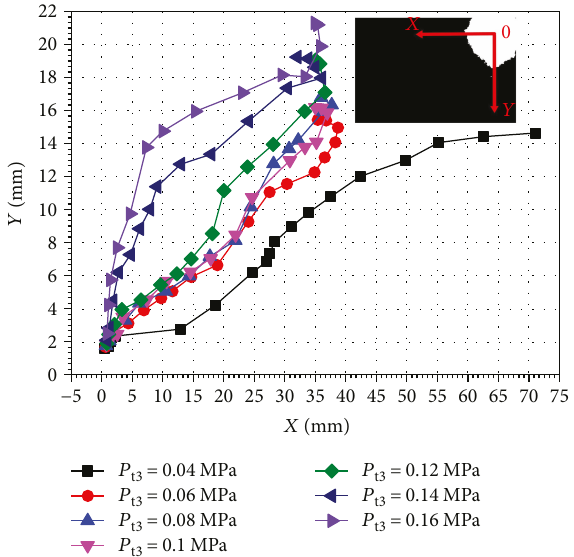
Figure 5: E ff ect of inlet pressure on the fl ame propagation trace of the fl ame